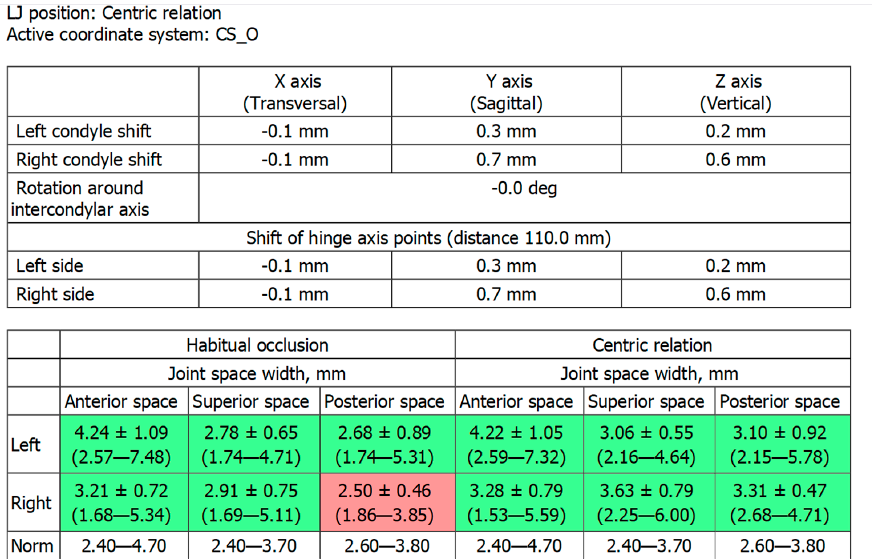
Figure 6. Table showed by the software. Intra-articular space widths in the right and left TMJs, before treatment (habitual occlusion, represented in the left part of the table) and in the one-stage virtual plan (centric relation, represented in the right part of the table). Posterior space width in the right TMJ passed from 2.5 mm to 3.31 mm, achieving a normal range. The upper part of the figure represents the mm of condylar repositioning. In the present case, the right condyle was moved 0.7 mm forward and 0.6 mm